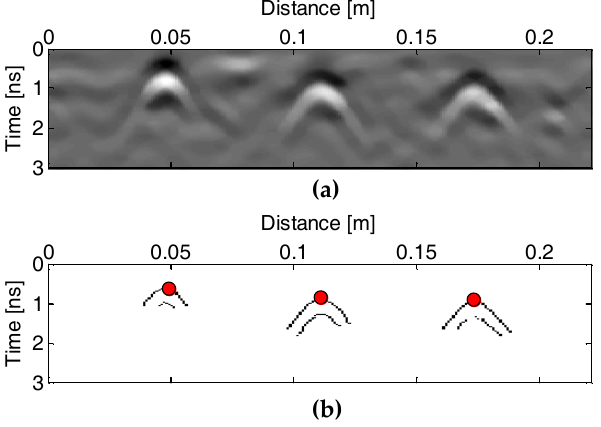
Figure 7. ( a ) GPR profile after preprocessing and ( b ) the corresponding binary image after the